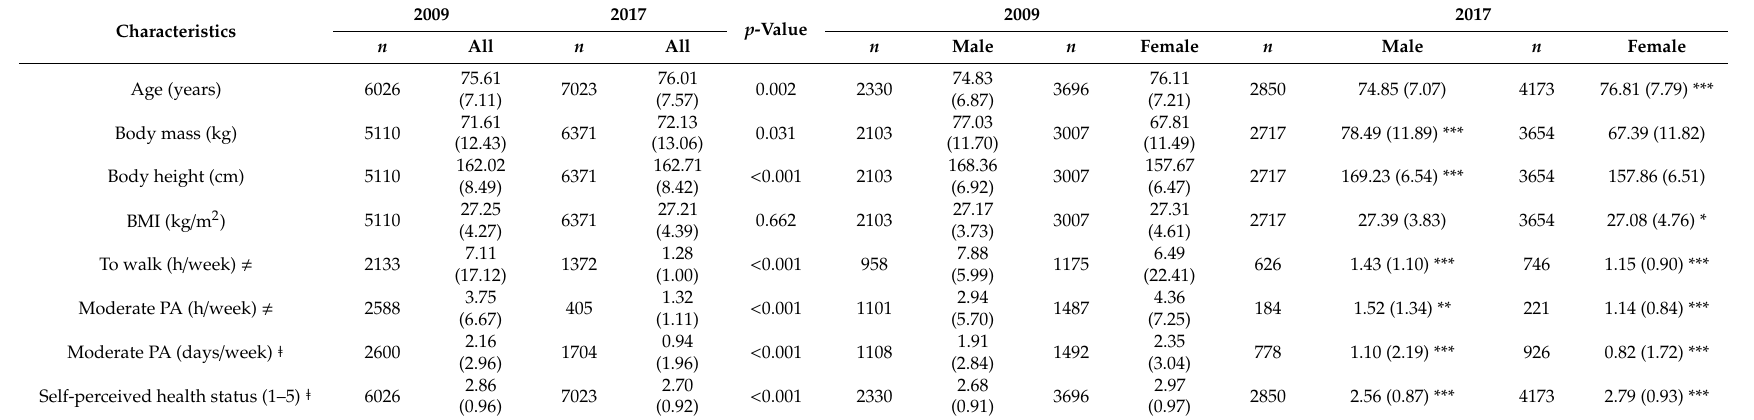
Table 1. Age, anthropometric variables, physical activity, and self-perceived health status regarding survey year and sex (mean ± SD (Standard Deviation)). Characteristics